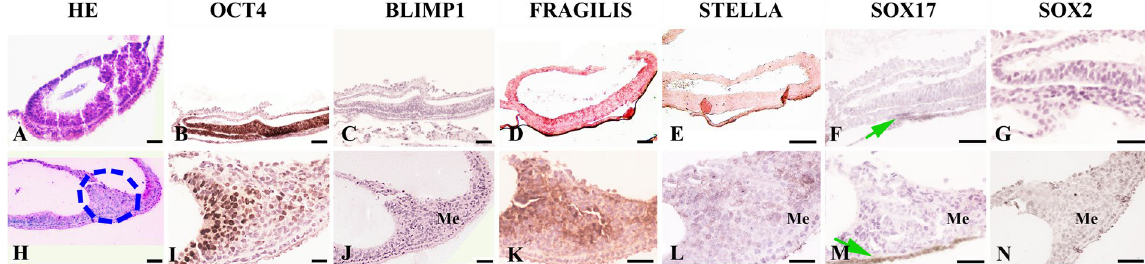
Figure 2. Expression and localization of germ line molecular markers in the embryo disc and primitive streak stage in Lagostomus maximus . ( A ) General view of the embryo disc (hematoxylin-eosin staining) and ( H ) primitive streak stage. ( B ) Widespread OCT4 positive expression in the ectoderm of the embryo disc. ( C ) BLIMP1, ( D ) FRAGILIS and ( E ) STELLA were not detected at the embryonic disc stage. ( F ) SOX17 detection in the visceral endoderm of the embryonic disc (green arrow). ( G ) Undetectable SOX2. ( I ) OCT4 positive migratory mesoderm cells during gastrulation ( K ) also expressing FRAGILIS in the primitive streak stage. ( J ) BLIMP1, ( L ) STELLA, ( M ) SOX17 and ( N ) SOX2 were not detectable in mesoderm cells in the primitive streak stage. Note that SOX17-expressing cells were found in the visceral endoderm (green arrow in M). I – N : detail of the circled area in H. Scale bar: 20 µ m ( A – D , H , J ); 40 µ m ( E – G , I , K – N